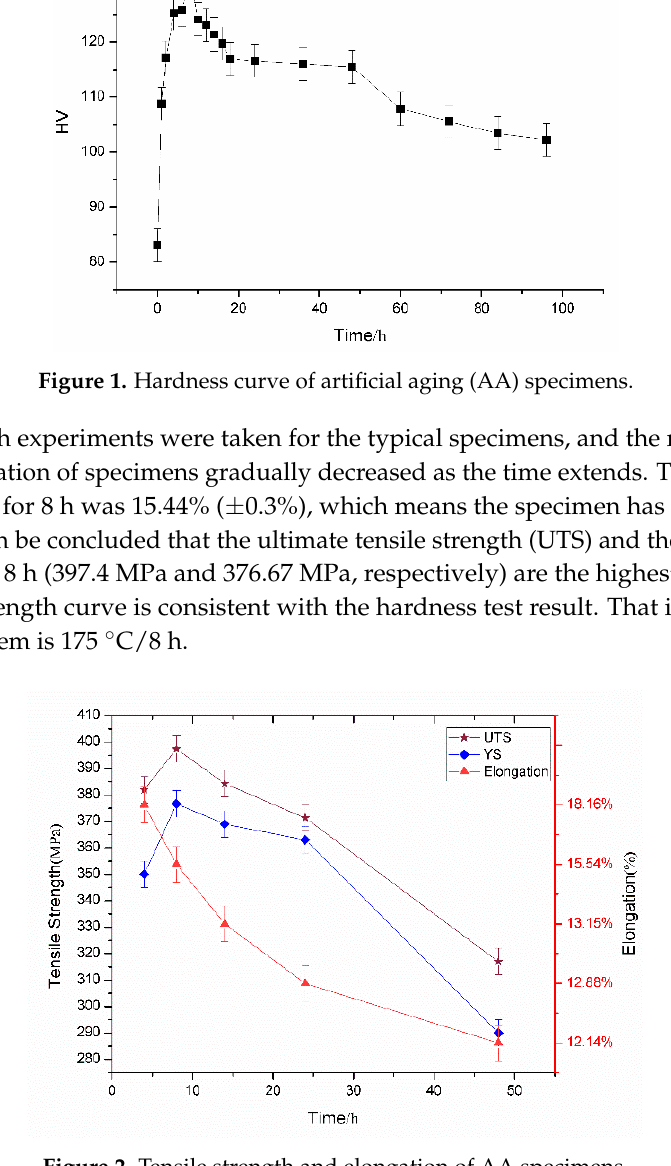
Figure 2. Tensile strength and elongation of AA specimens.